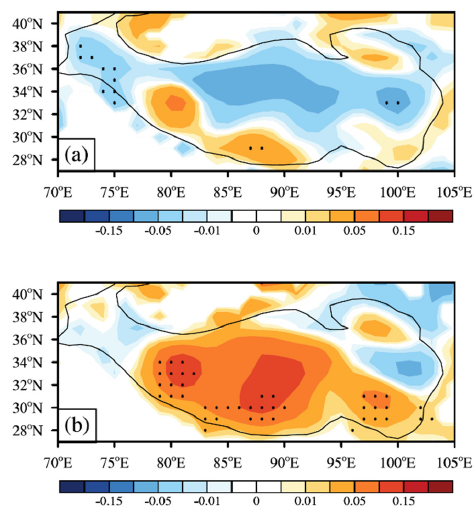
Figure 8. Trends (units: m s − 1 decade − 1 ) of the 10-m horizontal wind over the TP during 1979–2017 in different seasons ( a ) spring (March–May), ( b ) winter (December–February). The black contour denotes the isoline of 3000 ‐ m elevation. The dots indicate significant trends at 95% confidence level using the student ‐ t test.